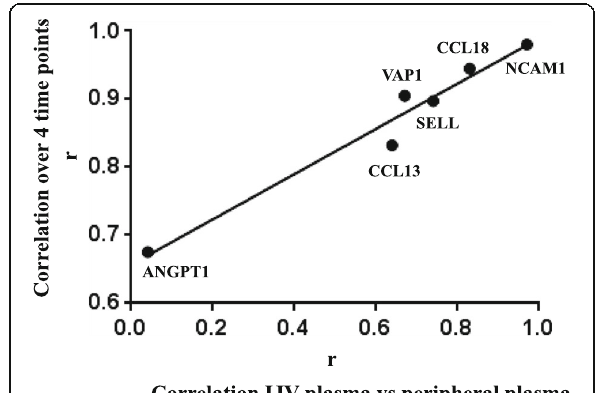
Fig. 3 Correlations of protein plasma levels: relation between 1st and 2nd MS population values. X axis: Pearson coefficients (r) of the correlation between jugular and peripheral plasma in 1st MS population. Y axis: Pearson coefficients (r) of the correlation over 4 time points in the peripheral plasma of the 2nd MS